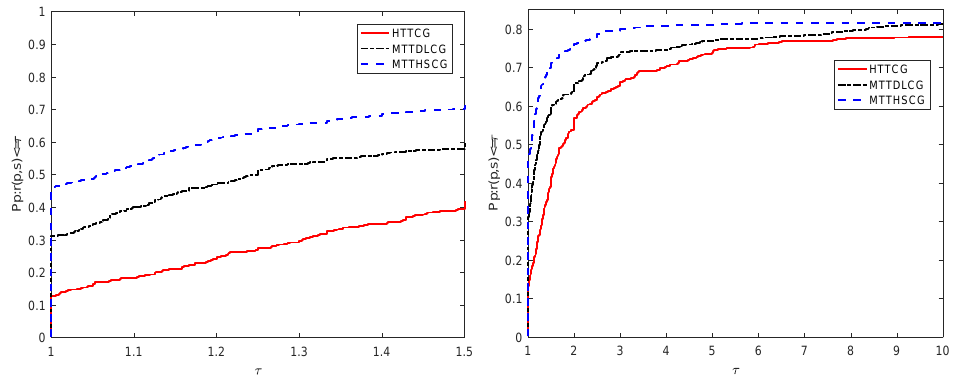
Figure 3. Performance profiles of the numerical results for these methods in CPU time consumed